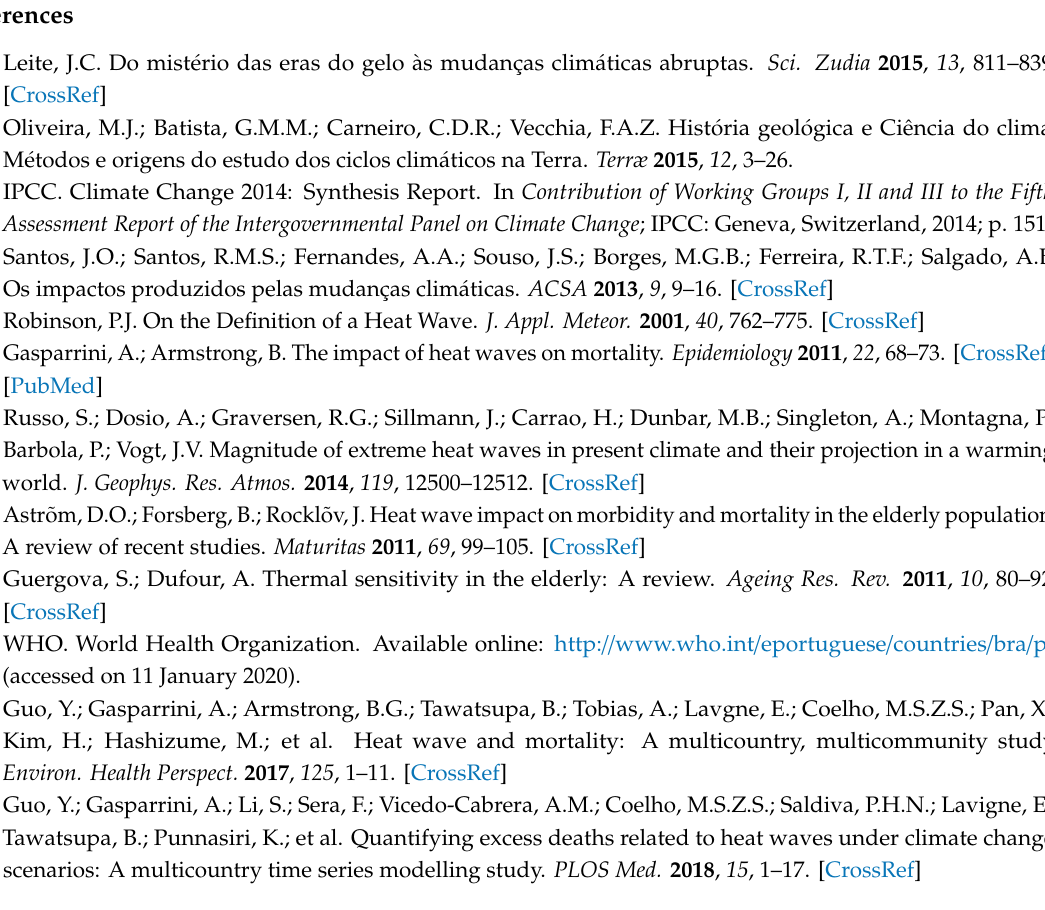
Figure S1: Lag response curve for main e ff ects of heat wave, Table S1: Di ff erence between of median of maximum temperature in the historical period and future period ( ∆ T ), File 1 S1: Code R, File 2 S1: Observed data, File 3